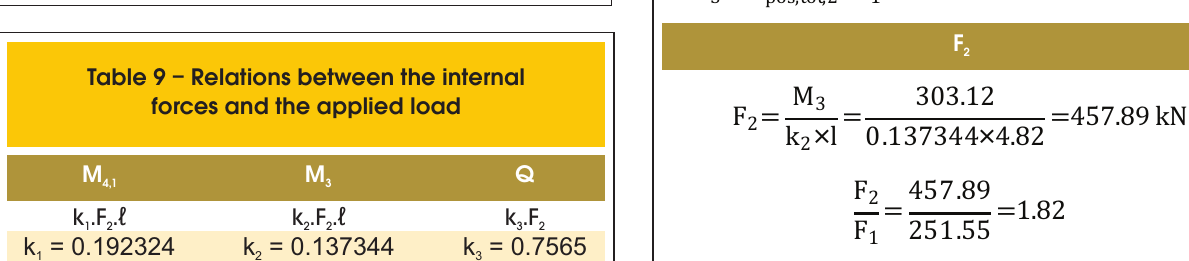
Table 9 – Relations between the